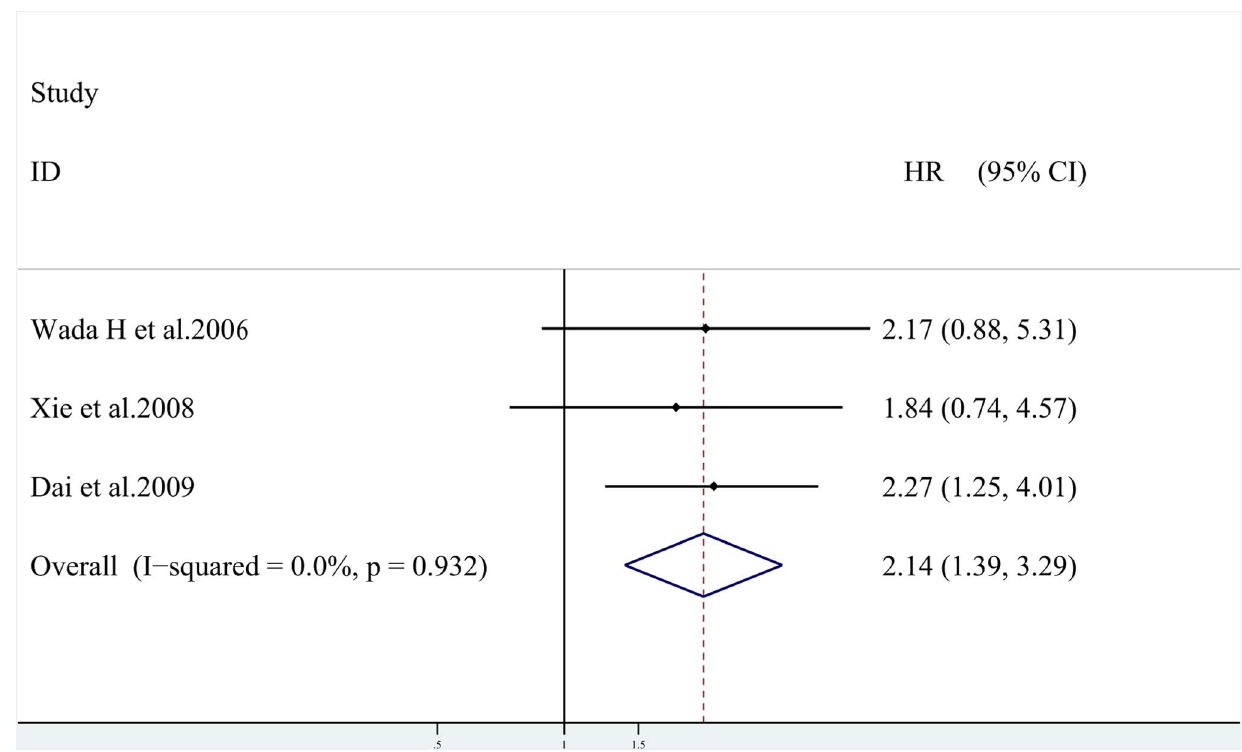
Figure 2. Plot illustrates findings from meta-analysis of the association between HIF-1 a overexpression and disease free survival (DFS) in 7 trials. Each study was shown by the name of the first author and the HR with 95% CIs. The summary HR and 95% CIs were also shown (according to the fixed effect estimations).